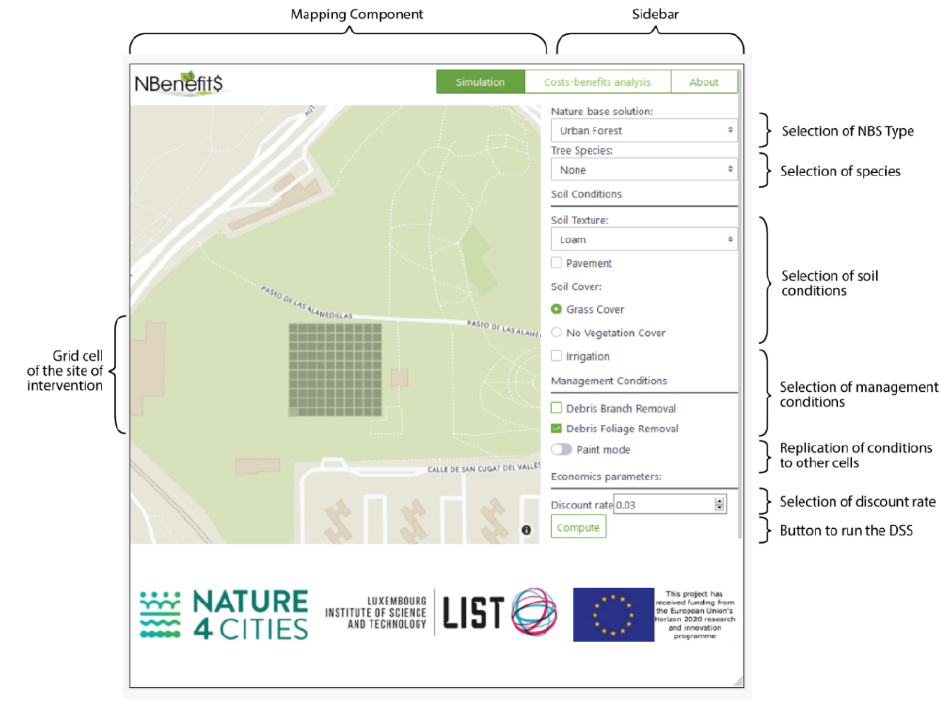
Figure 6. NBenefit$ web user interface, components, and description.